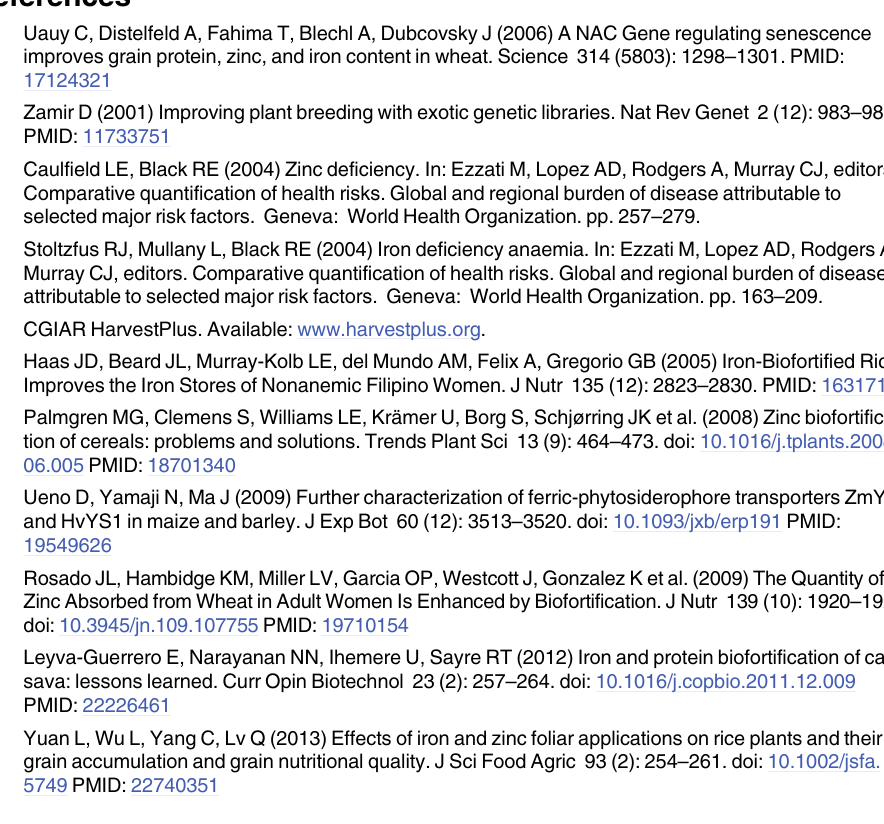
S4 Table. QTL for Cd, Zn and Fe concentrations in the senesced flag leaf. S5 Table. QTL for Cd, Zn and Fe concentrations in the young